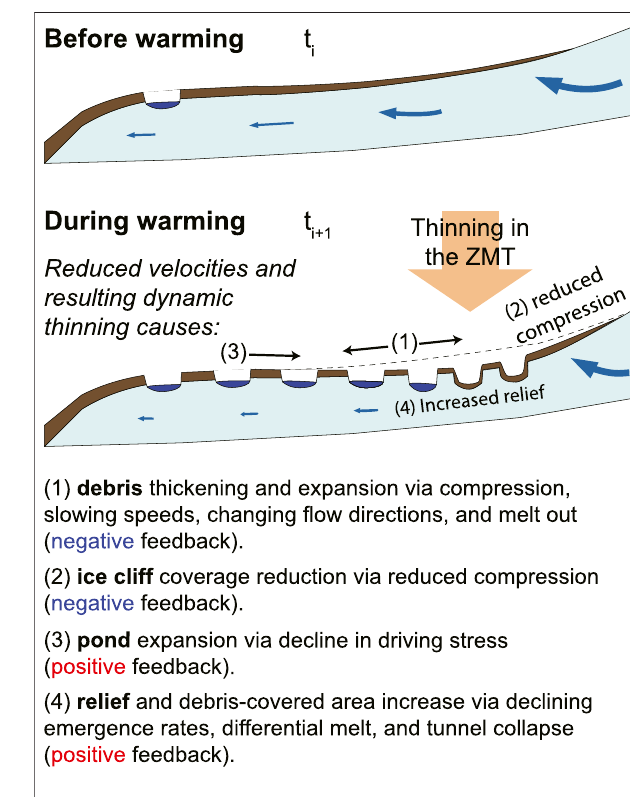
FIGURE 10 | Schematic explaining the feedbacks occurring on Kennicott Glacier over multiple decades. At time t i , the glacier has not yet started to respond to warming. The blue arrows qualitatively re fl ect englacial fl owpaths.Thelengthandwidthofthearrowre fl ectsthe fl owvelocity.At time t i+1 the glacier is responding to warming and thinning is localized in the zone of maximum thinning (ZMT). The downglacier portion of the ZMT shallows,whiletheupglacierportionoftheZMTsteepens.Thinningacrossthe glacier leads to reduced compression in